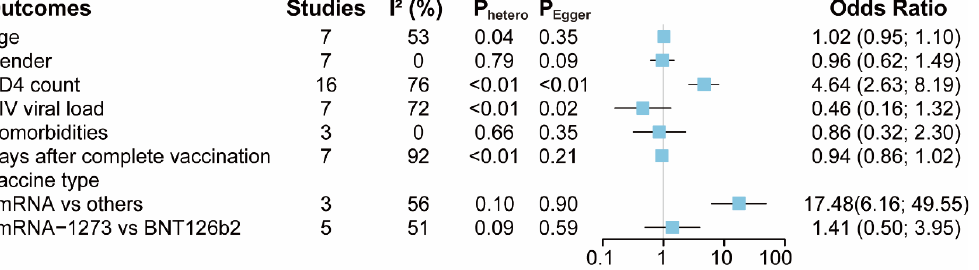
Figure 2. The pooled odds ratio of potential factors associated with seroconversion rate in people living with HIV ( PLWH). Comorbidities mean PLWH with cirrhosis, HBV or HCV coinfections.